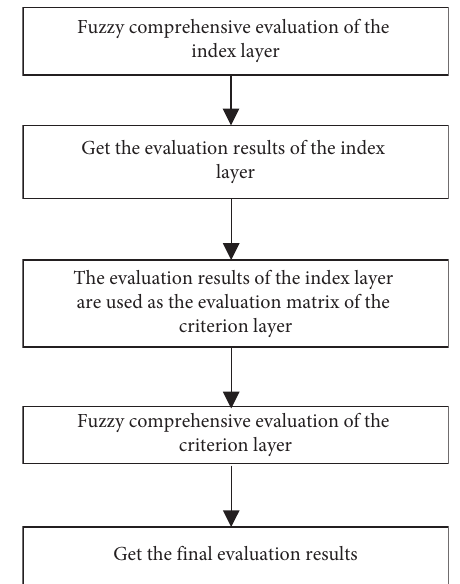
Figure 7: Flow chart of fuzzy comprehensive evaluation.